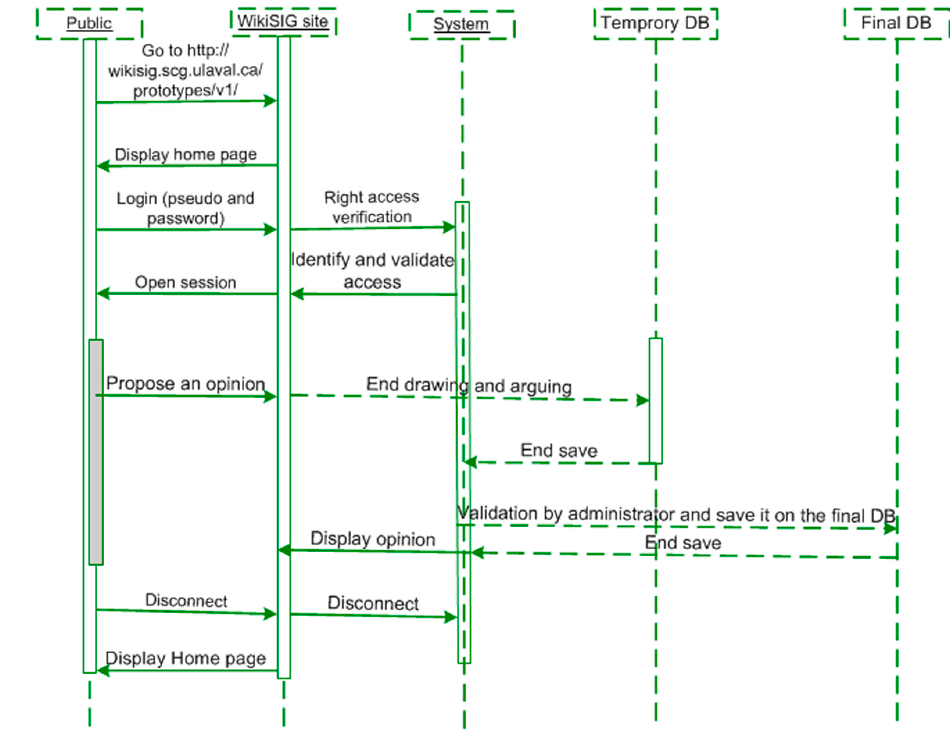
Figure 18. Sequence diagram of connected public when their opinion is accepted. Case 1: the proposed opinion is accepted by the administrator.